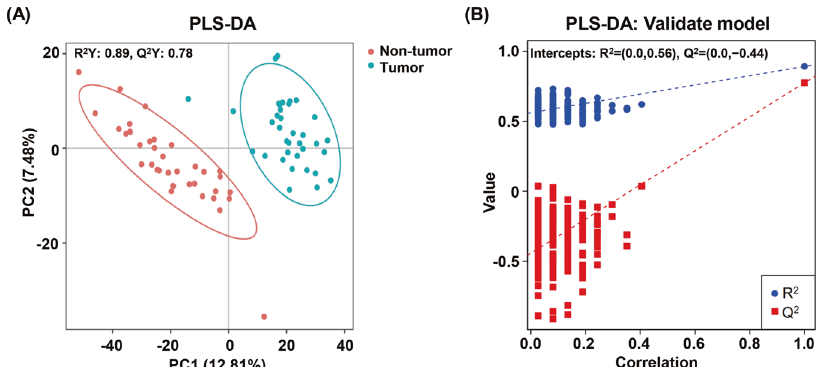
Fig. 2 The metabolome pro fi les of gastric cancer tissues were different from those of matched non-tumor tissues. A PLS-DA showed that tumor tissues and non-tumor tissues were separated into two distinct clusters. B The test for PLS-DA model showed that the PLS-DA model